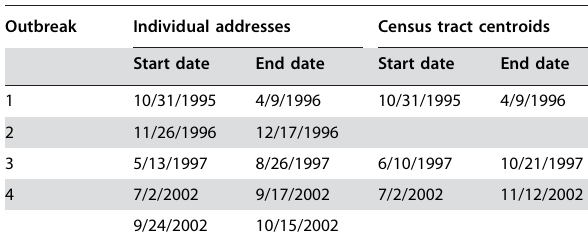
Table 1. Detection timeliness and sensitivity of the method applied to the confirmed p9 outbreaks using census